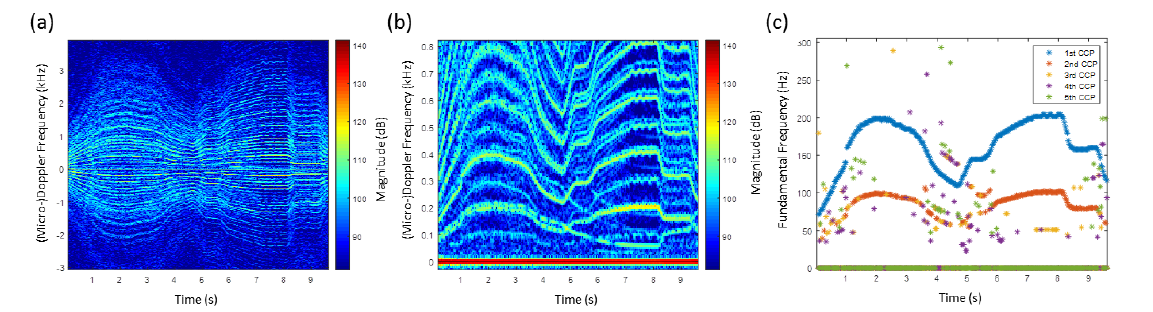
Figure 10. ( a ) HERM lines spectrogram for quadcopter measured by W-band radar; ( b ) zoomed into the HERM lines spectrogram showing individual HERM lines; ( c ) corresponding multi-frequency detector